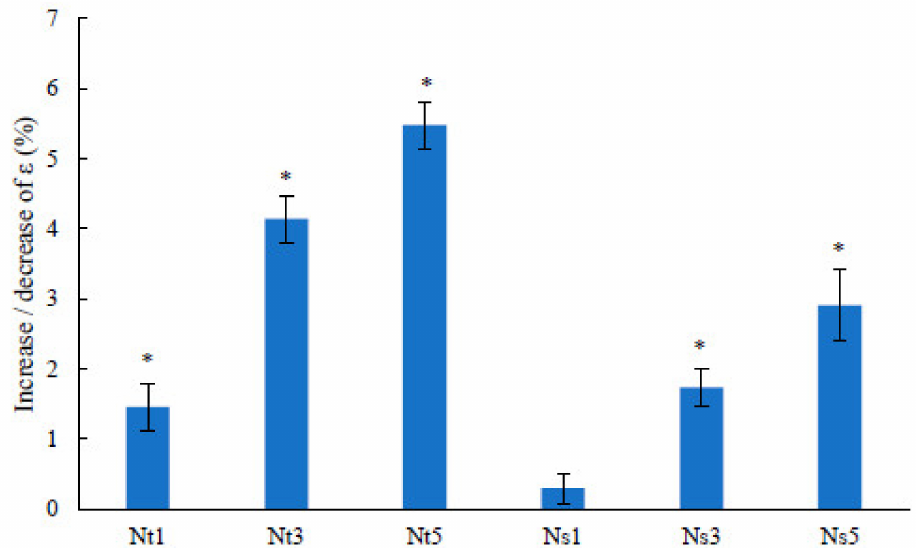
Figure 3. Elongation at break (percentage differences compared to samples without biocide). Sta- tistically significant differences ( p < 0.05) compared to the control (0) are marked with asterisks. Abbreviations: as in Table 1.